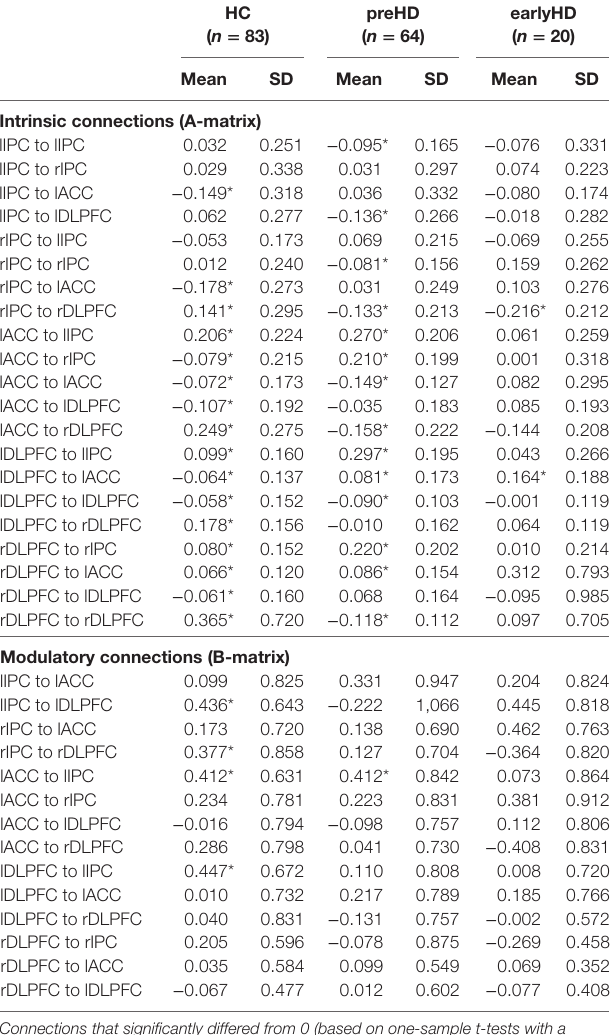
Table 3 | Descriptive statistics of dynamic causal modeling connection strengths.